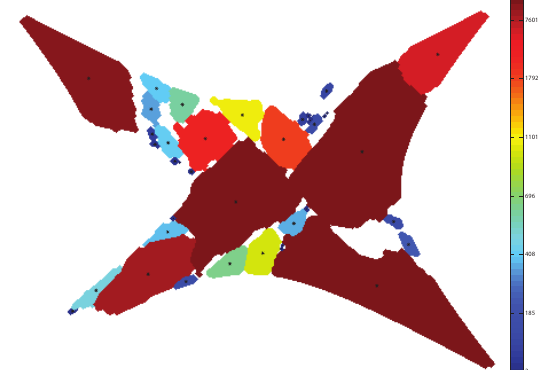
Figure 11: Shipboard sea-ice image with fisheye distor- tion and its segmentation result.